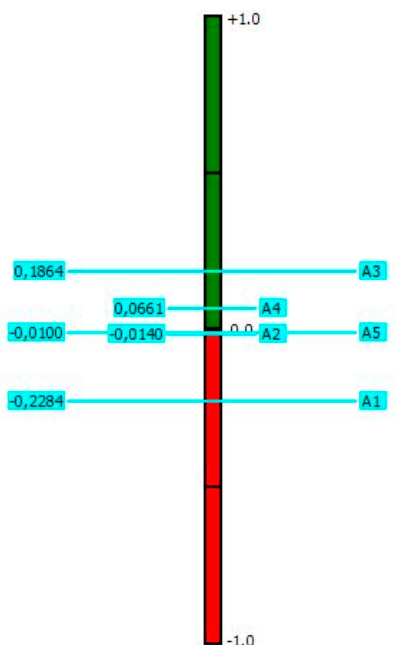
Figure 3. Final ranking. Tailings—A1-Žarkov Potok; A2—Gornje Polje; A3–Žitkovac; A4—Tvr đ anski Do; A5—Bostanište.